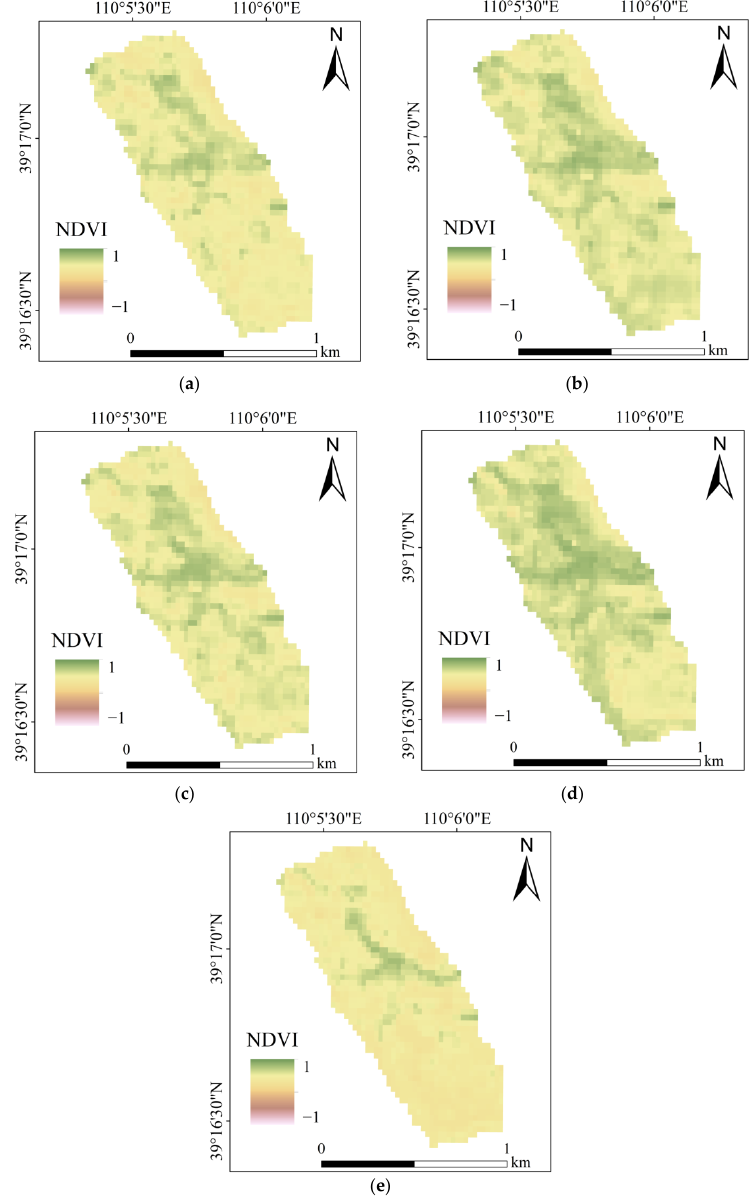
Figure 5. The NDVI of the study area: ( a ) 2017; ( b ) 2018; ( c ) 2019; ( d ) 2020; ( e ) 2021.